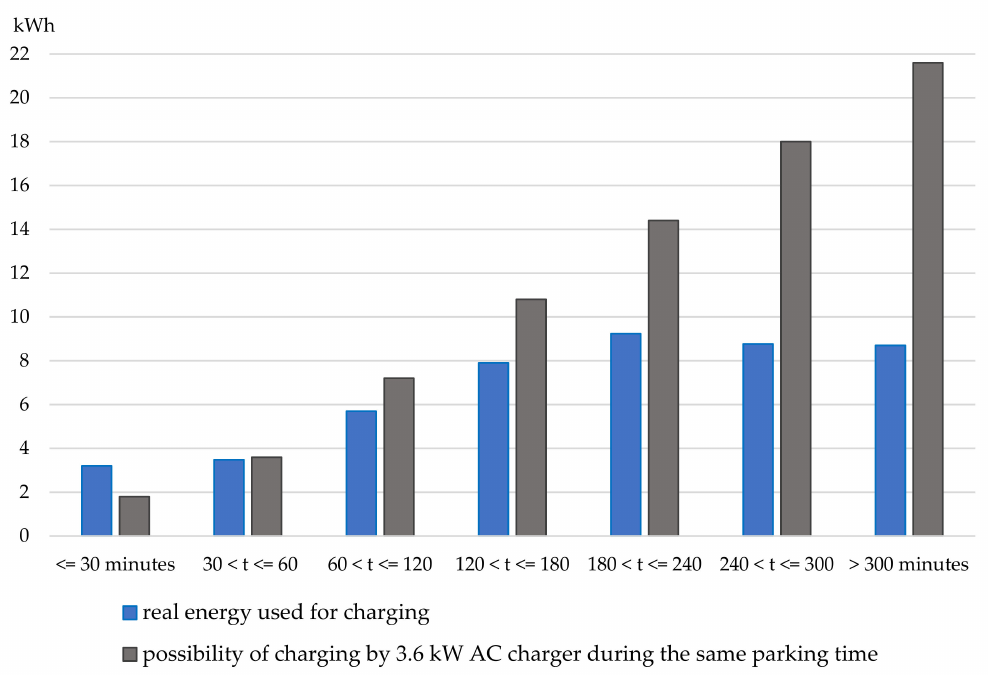
Figure 4. Charging requirements of electric vehicles obtained from PRE charging stations ([65], compiled and calculated by